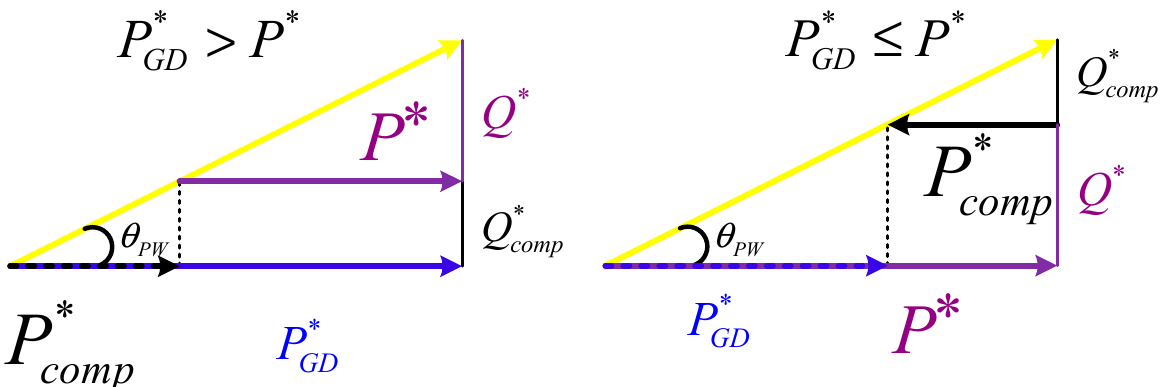
Figure 11. Size of reactive power according to active power.